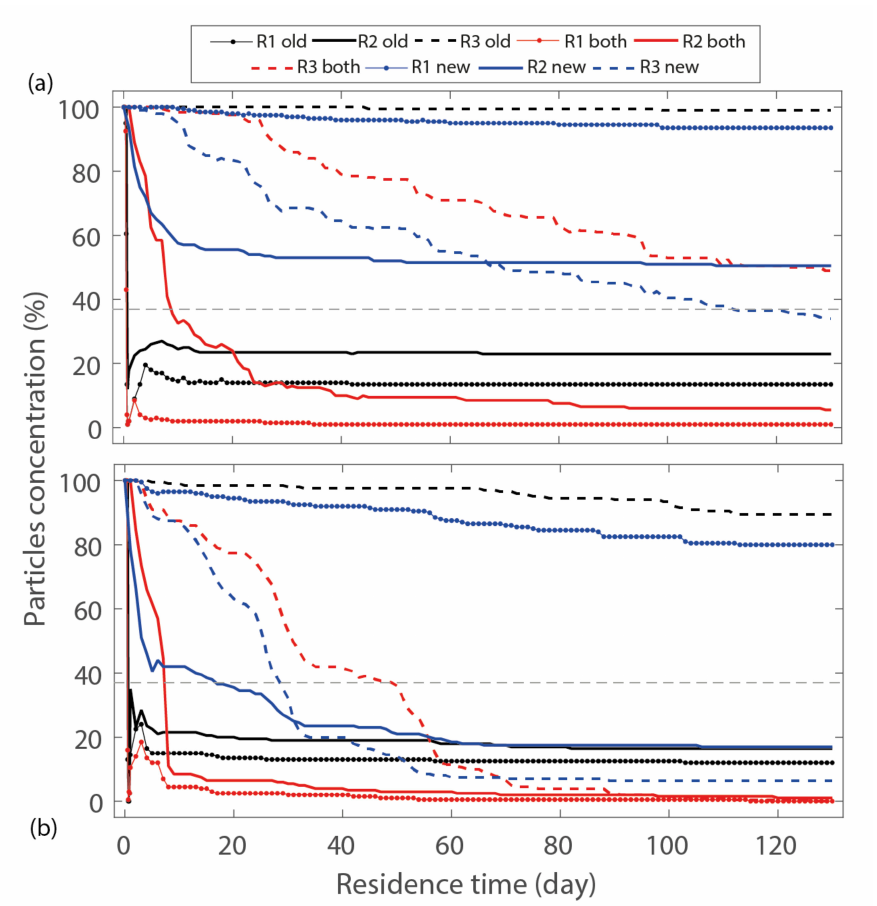
Figure 11. Particles concentration within the Setiu Lagoon under different inlet configurations released from R1, R2 and R3 during the ( a ) southwest and ( b ) northeast monsoons. The time when the particles concentration reaches 37% of its original values is presented in grey dash